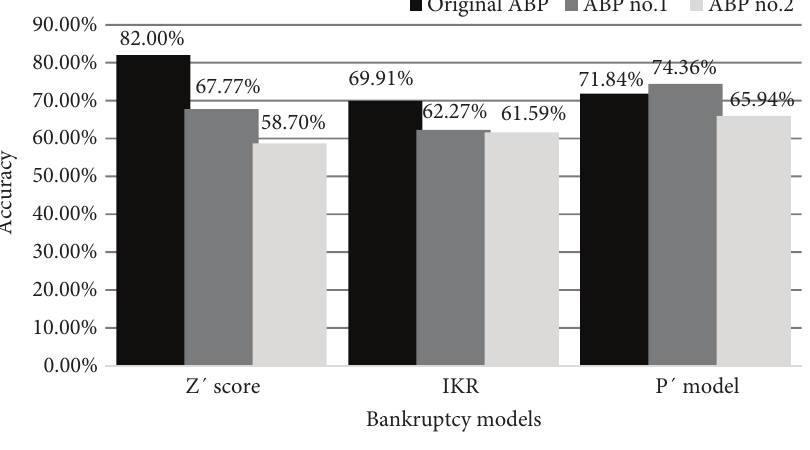
Figure 2. Accuracy of models in failure prediction (source: